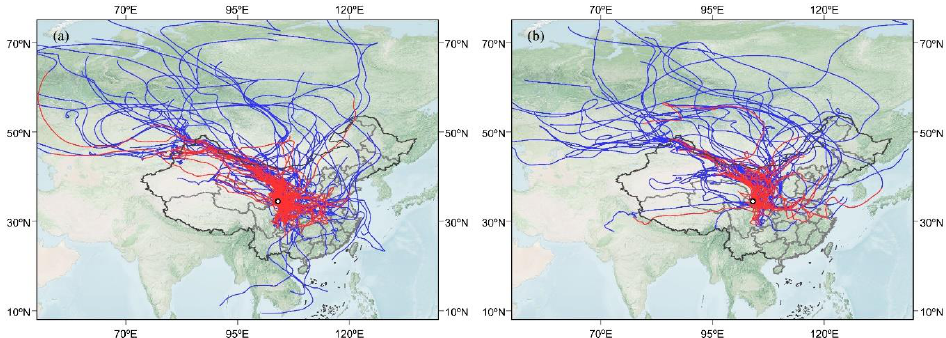
Figure 5. The water vapor transport trajectories of Minxian Station in the summer half-year ( a ) and winter half-year ( b ), the red line is the trajectory after specific humidity correction, and the blue line is the trajectory without specific humidity correction.